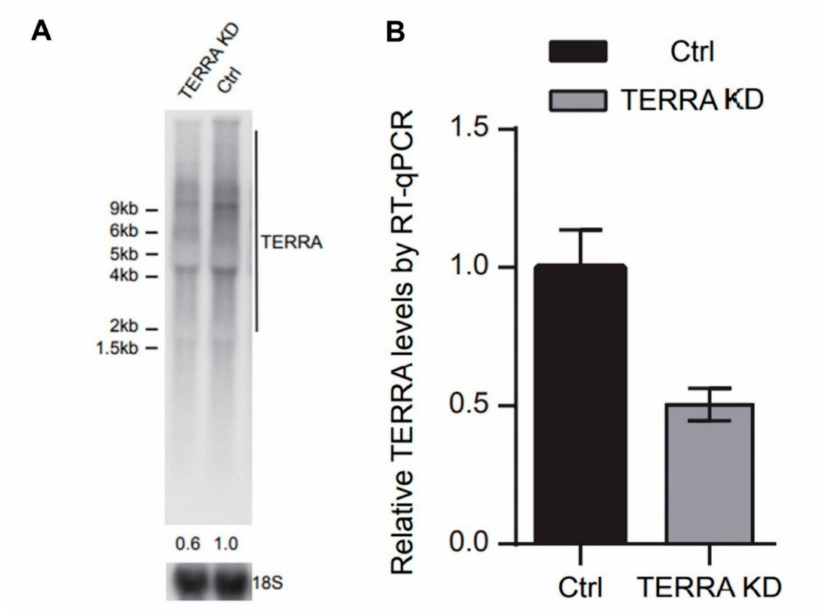
Figure 5. TERRA level detected by RT-qPCR is comparable with the results of northern blot analysis. ( A ) Northern blot analysis for detection of TERRA RNA level in U2OS cells after TERRA knockdown (KD). The TERRA levels were normalized with 18S rRNA expression levels. ( B ) RT-qPCR analysis for detection of TERRA level in U2OS cells after TERRA knockdown. The TERRA levels were normalized with beta-2 microglobulin (B2M) RNA expression